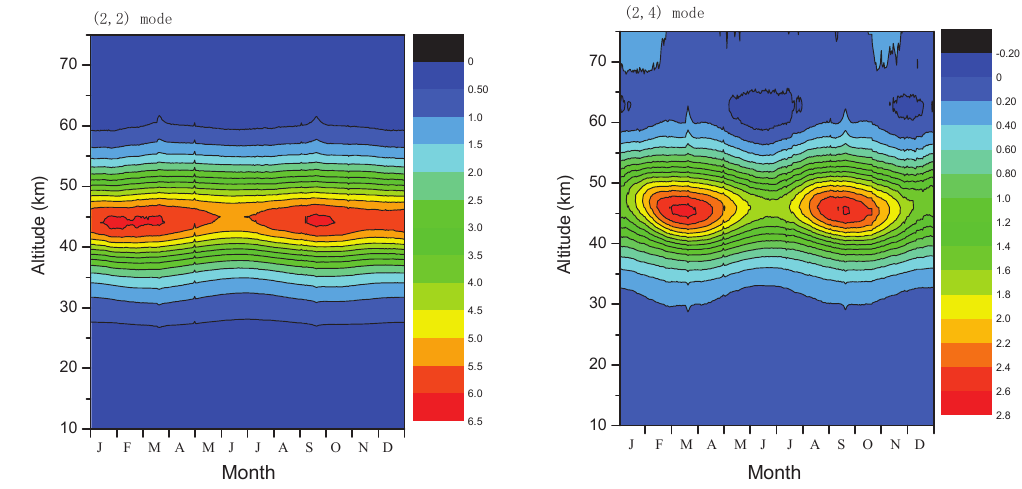
Figure 10 The multi-year averaged vertical profiles of the symmetrical (a) and asymmetrical (b) semidiurnal Hough functions for equinox/Mar (solid line) and solstice/Jun (dashed line). Fig. 11. Time-altitude cross-sections of the monthly averaged amplitudes of the semidiurnal Hough modes (2,2) and (2,4).